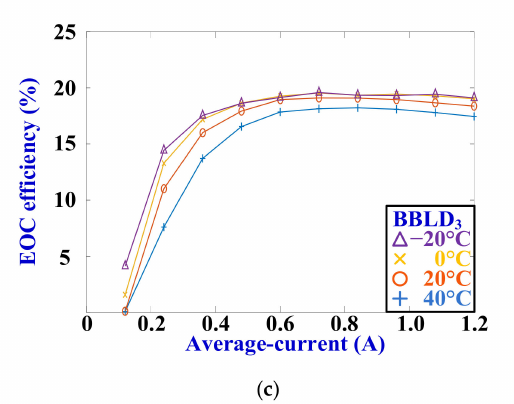
Figure 10. Electro-optic conversion (EOC) e ffi ciency ( η avg ) variations in average current modulation. ( a ) BBLD 1 . ( b ) BBLD 2 . ( c ) BBLD 3 .